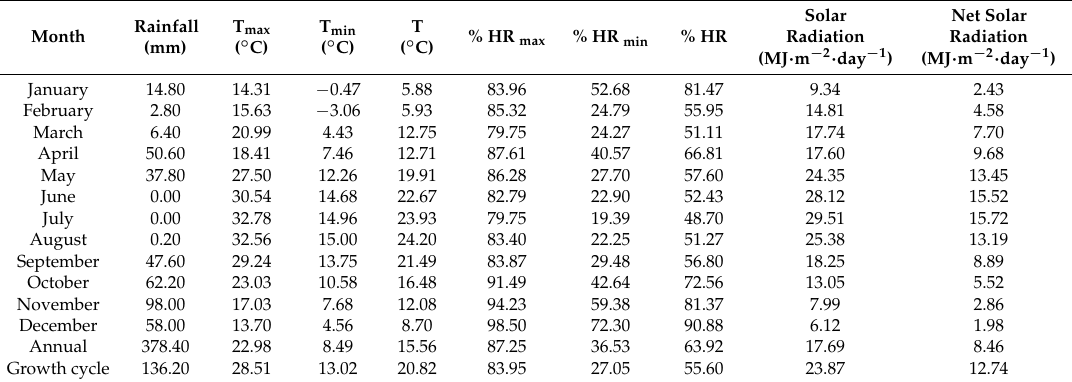
Table 3. Environmental conditions during the 2012 growth